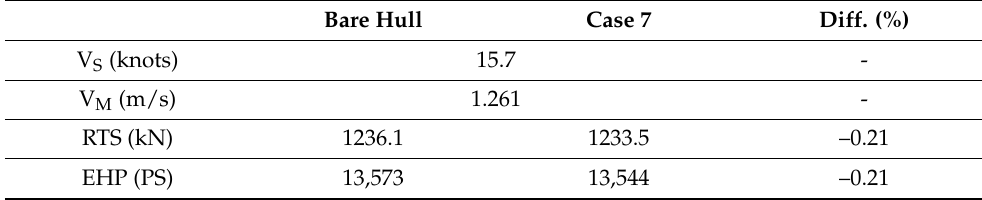
Figure 15. The model ESD of 158K crude oil tanker (Case 7). Table 13. Results of the resistance model test.